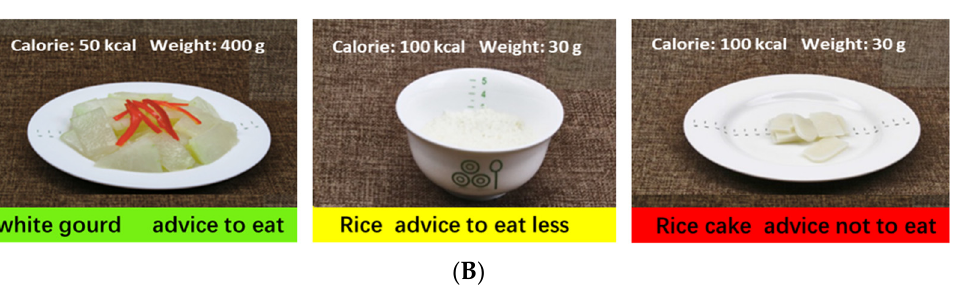
Figure 2. The food management tools. ( A ). The dinner set; ( B ). Contents of the guiding